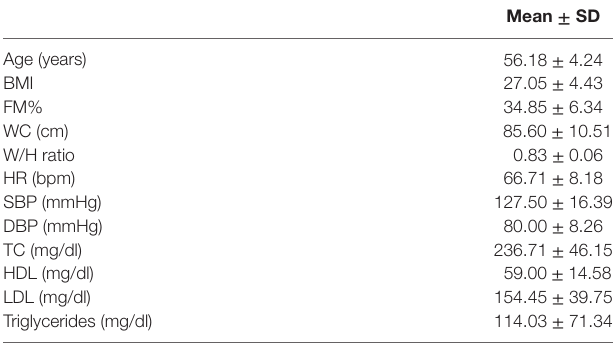
Table 1 | Physiological and anthropometric characteristics of the